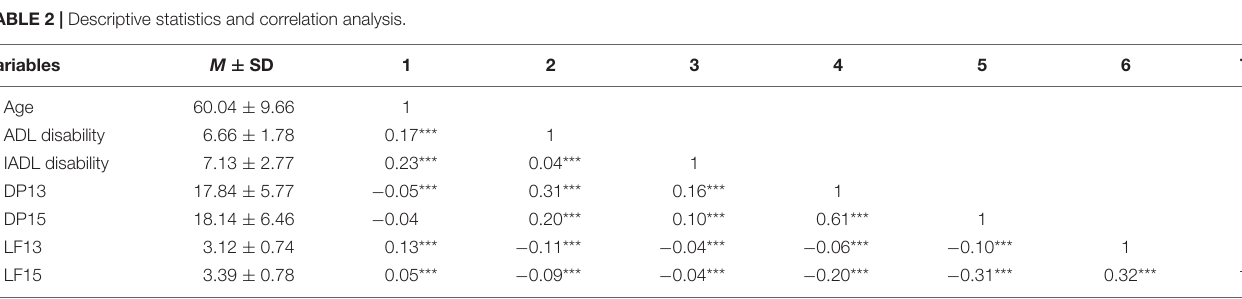
TABLE 2 | Descriptive statistics and correlation